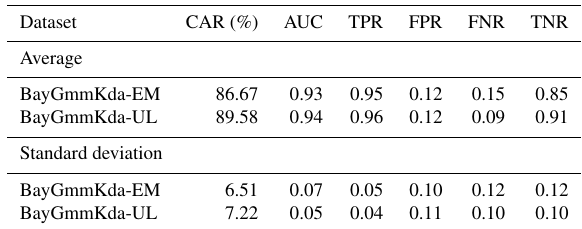
Table 2. Prediction results of